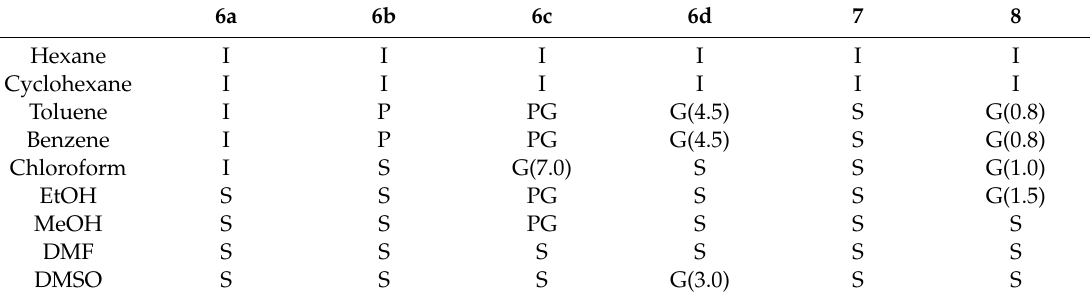
Table 2. Gelation properties of compounds ( 6a – d , 7 , 8 ) in various solvents a .